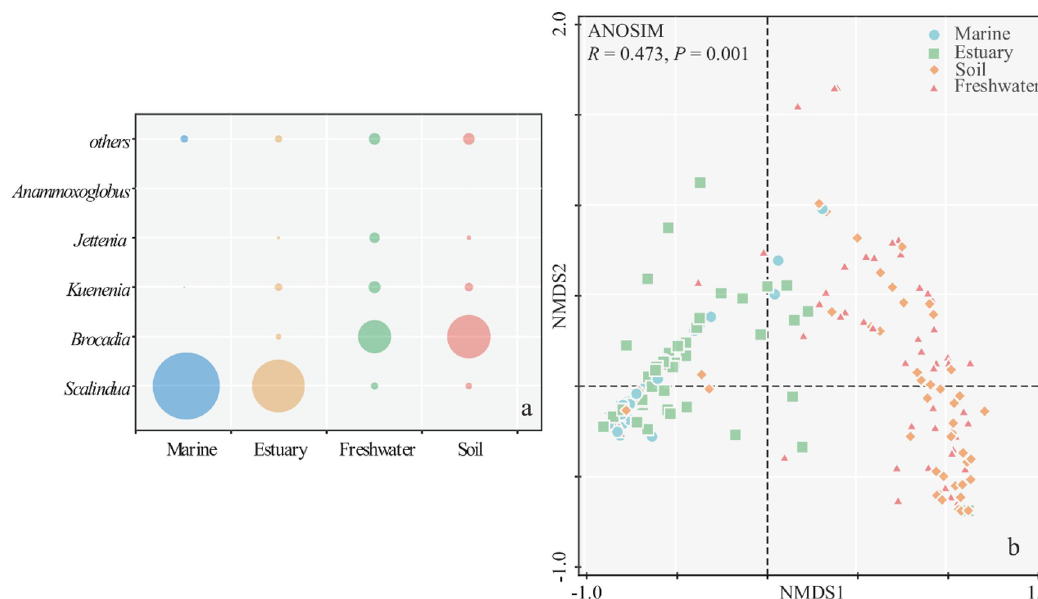
Fig 2. Anammox bacterial community composition in different habitats (a), and NMDS ordination based on Bray-Curtis distance of the sequences affiliation to each genera (b).